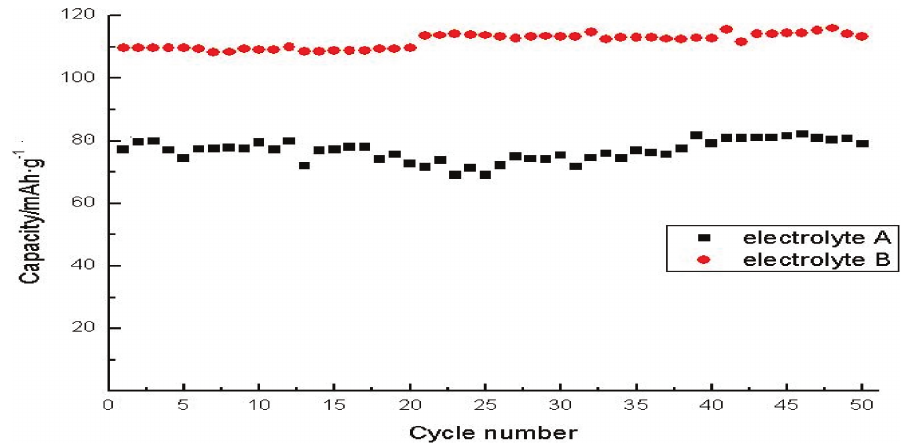
Fig. 7: Cycle performances of LiNi 0.5 Mn 1.5 O 4 coin cells with two different kinds of